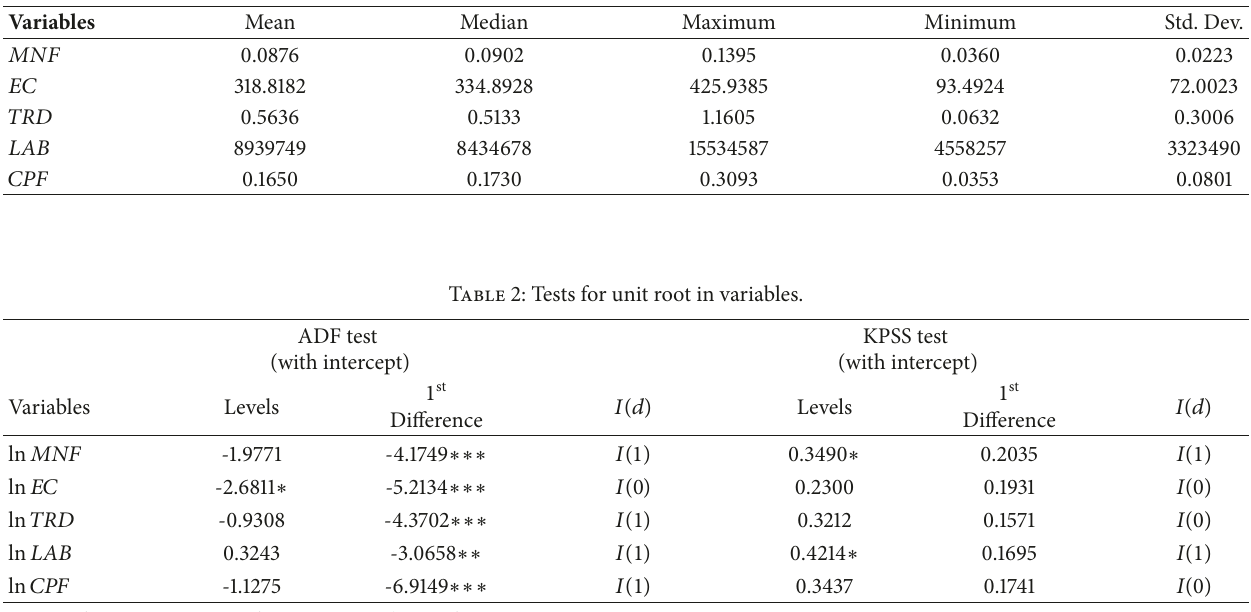
Table 1: Descriptive statistics of the variables.